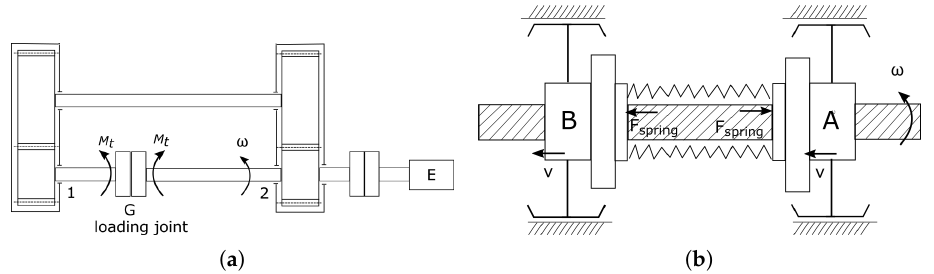
Figure 1. Comparison of the adoption of recirculating power principle in gear and ball screw test bench. ( a ) Gear test bench concept. ( b ) Ball screw test bench